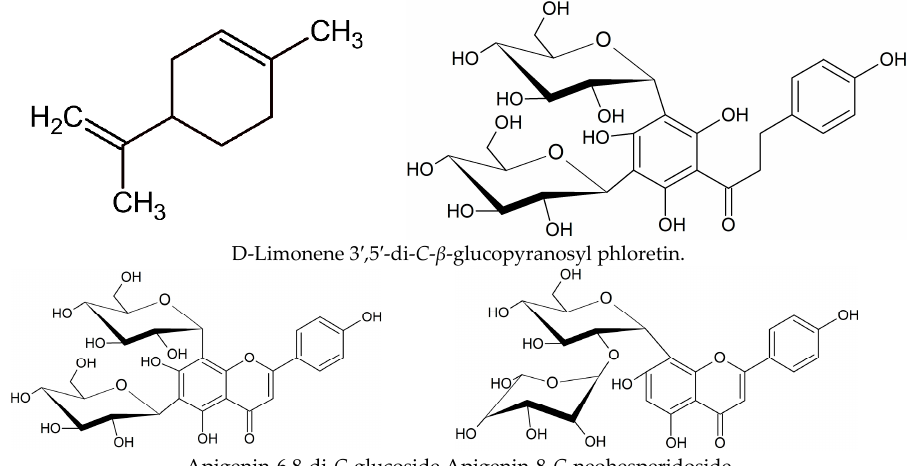
Figure 2. Chemical structures of D-Limonene; 3 ′ ,5 ′ -di- C - β -glucopyranosyl phloretin;